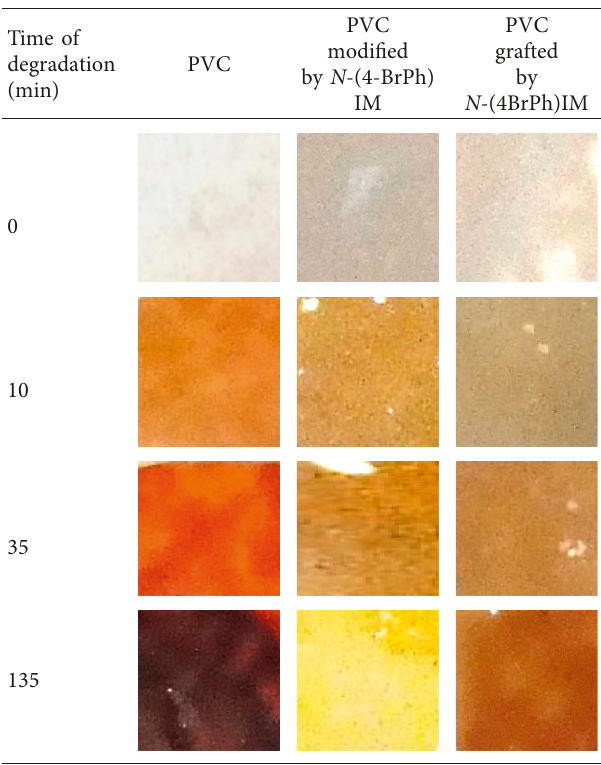
Table 4: Effect of thermal degradation at 180 ° C, in air, on the discoloration of the PVC modified and grafted by N -(4BrPh)IM as compared to